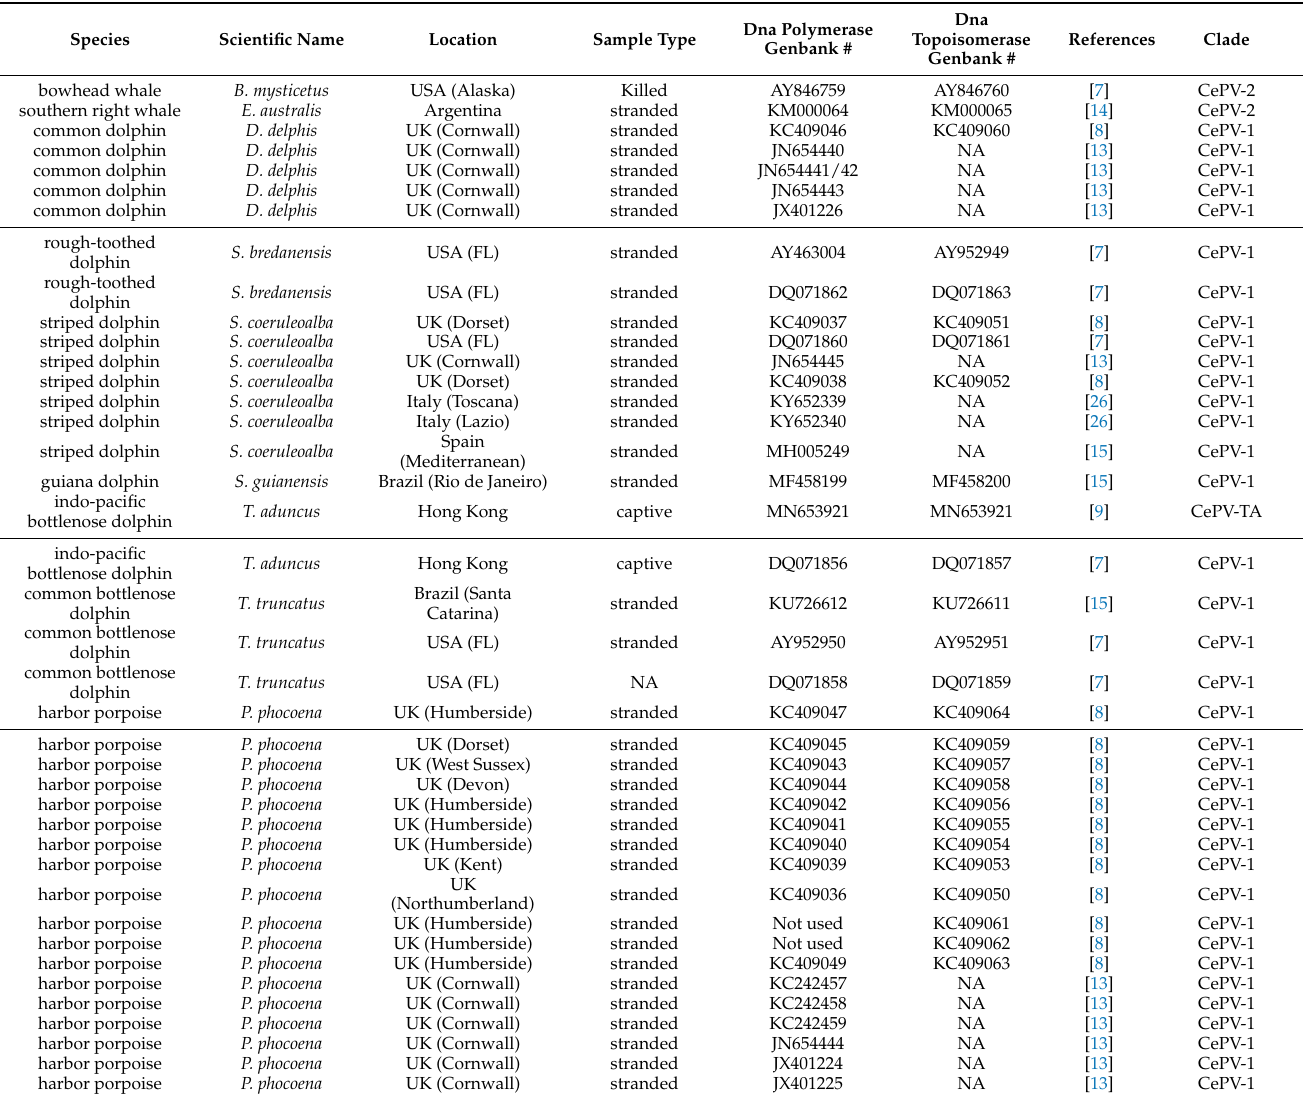
Table 2. Species, location, sample type, reference and GeneBank accession number (#) of the cetacean poxviruses used in the phylogenetic trees; NA: not